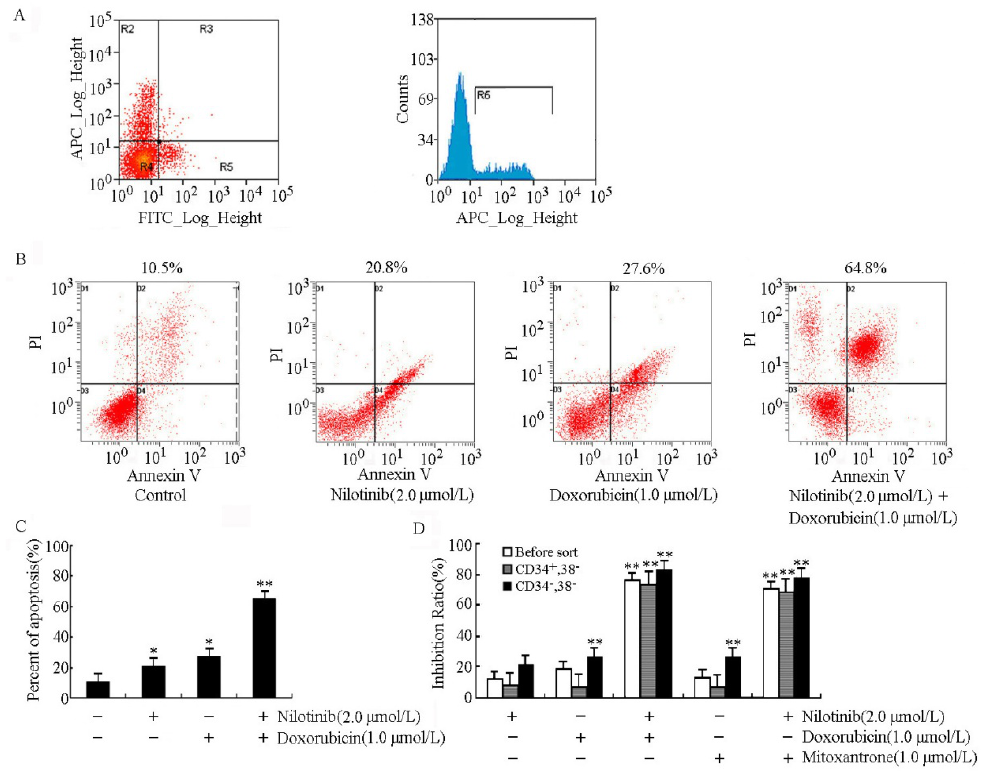
Figure 1. Nilotinib targeted CD34 + CD38 − cells and enhanced the efficacy of doxorubicin and mitoxantrone in the inhibition of proliferation and induction of apoptosis. ( A ) BM mononuclear cells isolated from acute myeloid leukemia patients were co-stained with anti-CD34 and -CD38 antibodies and CD34 + CD38 − cell-enriched subpopulation was further sorted by FACS. ( B ) and ( C ) Sorted CD34 + CD38 − cells treated with doxorubicin and nilotinib in the indicated concentrations for 48 h, respectively. Apoptosis was analyzed by flow cytometry as the percentage of cells labeled by Annexin V and propidium iodide. ( D ) Induction of 50% cell death by doxorubicin and mitoxantrone in the presence of nilotinib at indicated concentrations. Growth inhibition was determined by the MTT assay according to the protocol described in the Experimental section. All these experiments were repeated at least thrice, and a representative experiment is shown. Columns, means of triplicate determinations; * p < 0.05; ** p <